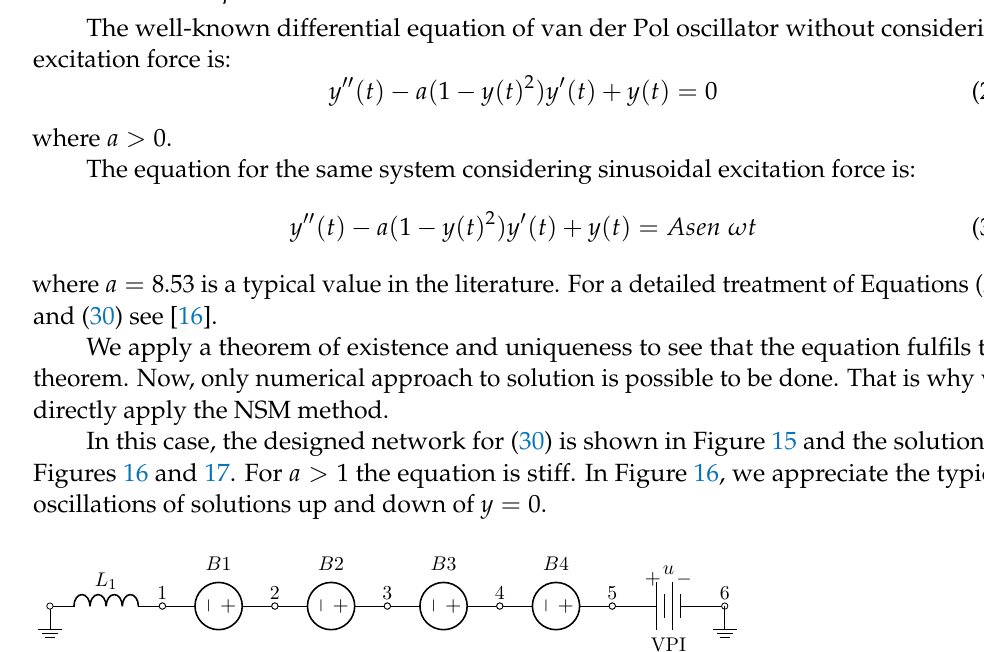
Figure 13. Parabolic mirror from NSM